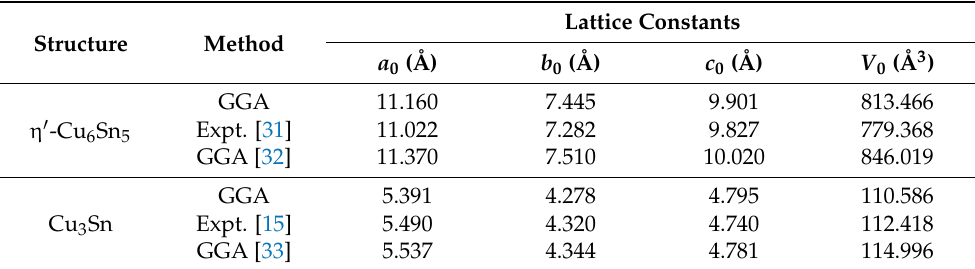
Table 1. The lattice constants of η (cid:48) -Cu 6 Sn 5 and Cu 3